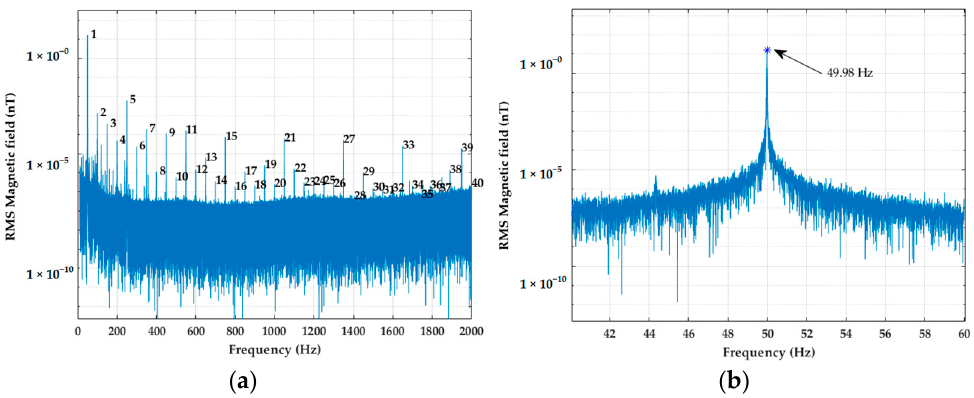
Figure 7. ( a ) Peak search; ( b ) Peak near the fundamental component.